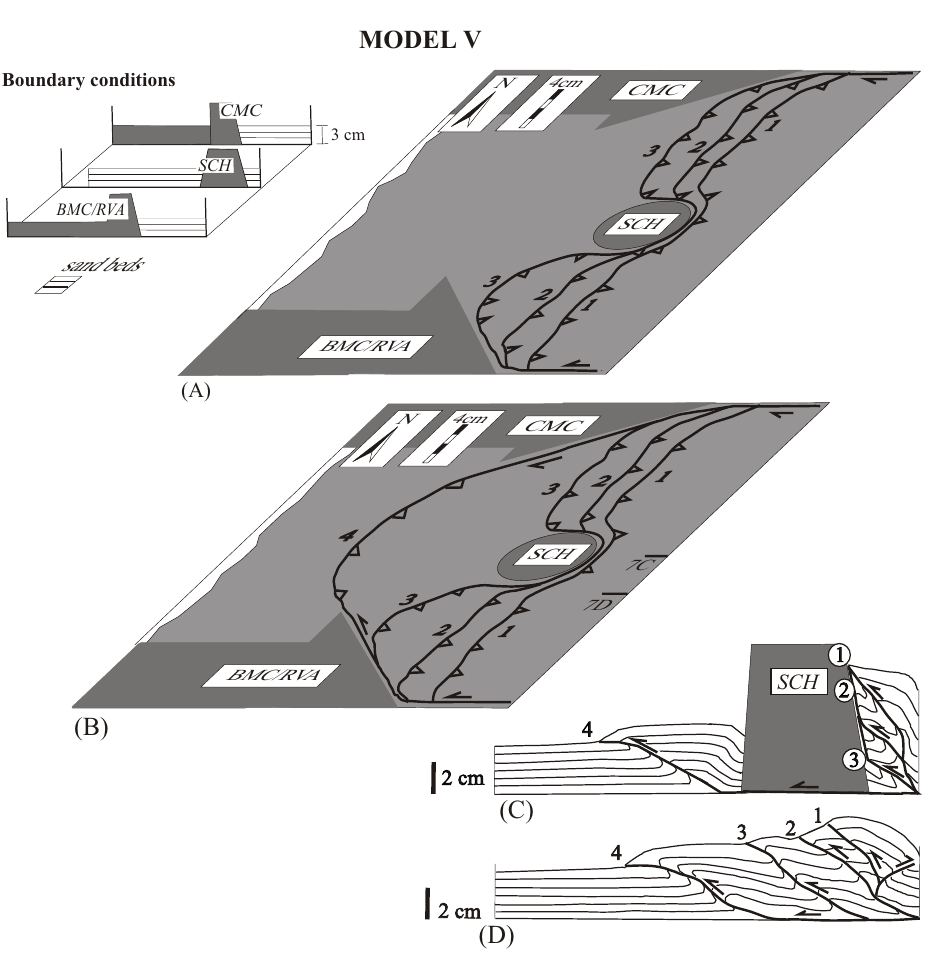
Fig. 7 – Plan-view and profile line drawings of model V which simulates the Serra do Caraça structural high between the Caetés Metamorphic Complex and the Bação Metamorphic Complex/Rio dasVelhasArch structural highs. A – The thrust traces in plan-view after 16% (6 cm) shortening with the Serra do Caraça structural high acting as a fixed obstacle. B – The same thrusts after 21.5% shortening with the Serra do Caraça structural high dislocated 2 cm into the foreland. In B, the youngest fault (fault 4) represents the frontal ramp of the leading edge of the Fundão-Cambotas Fault System, and faults 1, 2 and 3 simulate the Água Quente Fault System. At the eastern margin, the positions of the vertical profiles are indicated. C – and D- Vertical sections showing the thrusts in profile. Note in section C, the strongly rotated thrusts of theÁgua Quente Fault System in the hinterland of the Serra do Caraça structural high. Numbers 1 to 4 indicate the order of fault formation. SCH – Serra do Caraça structural high; CMC – Caetés Metamorphic Complex; BMC/RVA – Bação Metamorphic Complex/Rio das Velhas